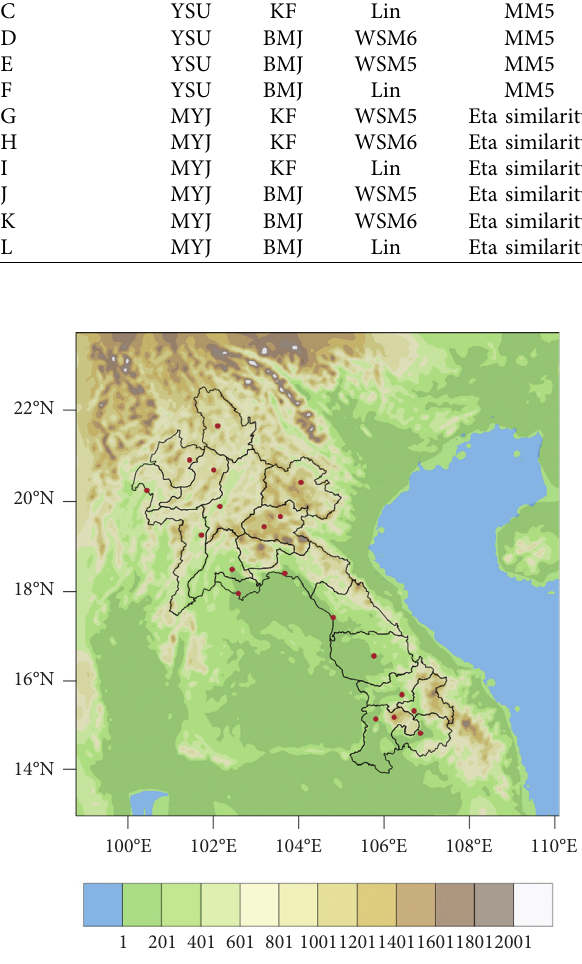
Figure 2: The terrain in meters above sea level of domain 2 and the DMH observation data collection locations (red) in Lao